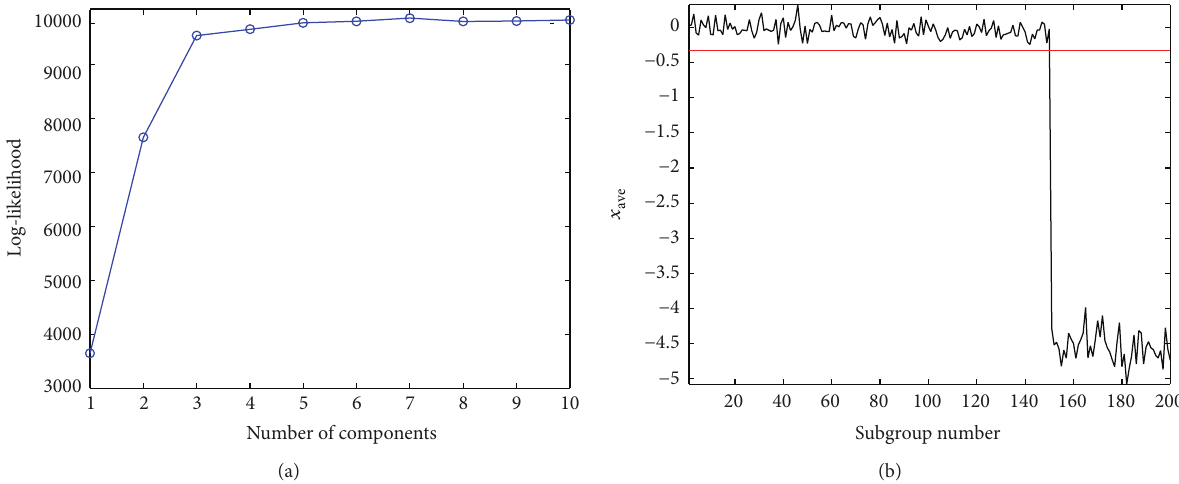
Figure 5: Log-likelihood with the penalty term (a) and Shewhart control chart for damage detection (b).